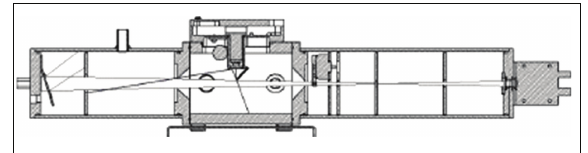
FIGURE 1: Illustration of the Aurora 3000 nephelometer.